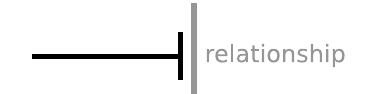
Figure 2.23: The Entity Relationship glyph for inhibition .